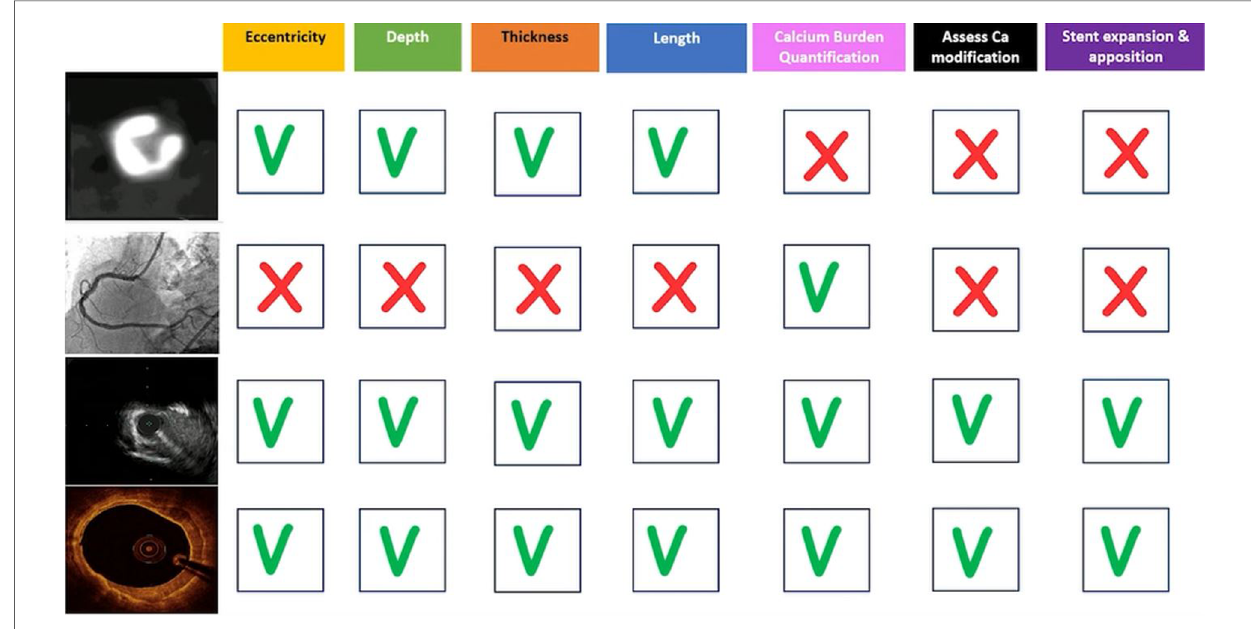
FIGURE 9 Summary of coronary artery calci fi cation patterns and which imaging modalities are best suit to quantify each variable as well as which modalities may be used intraprocedurally to assess stent